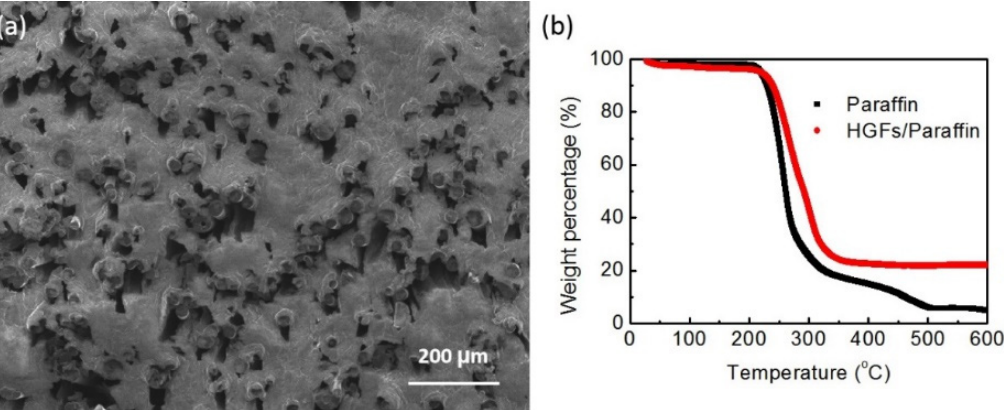
Figure 4. SEM image of the HGFs/Paraffin composite ( a ) and the TGA curves of HGFs/Paraffin wax composite and pure paraffin ( b ).